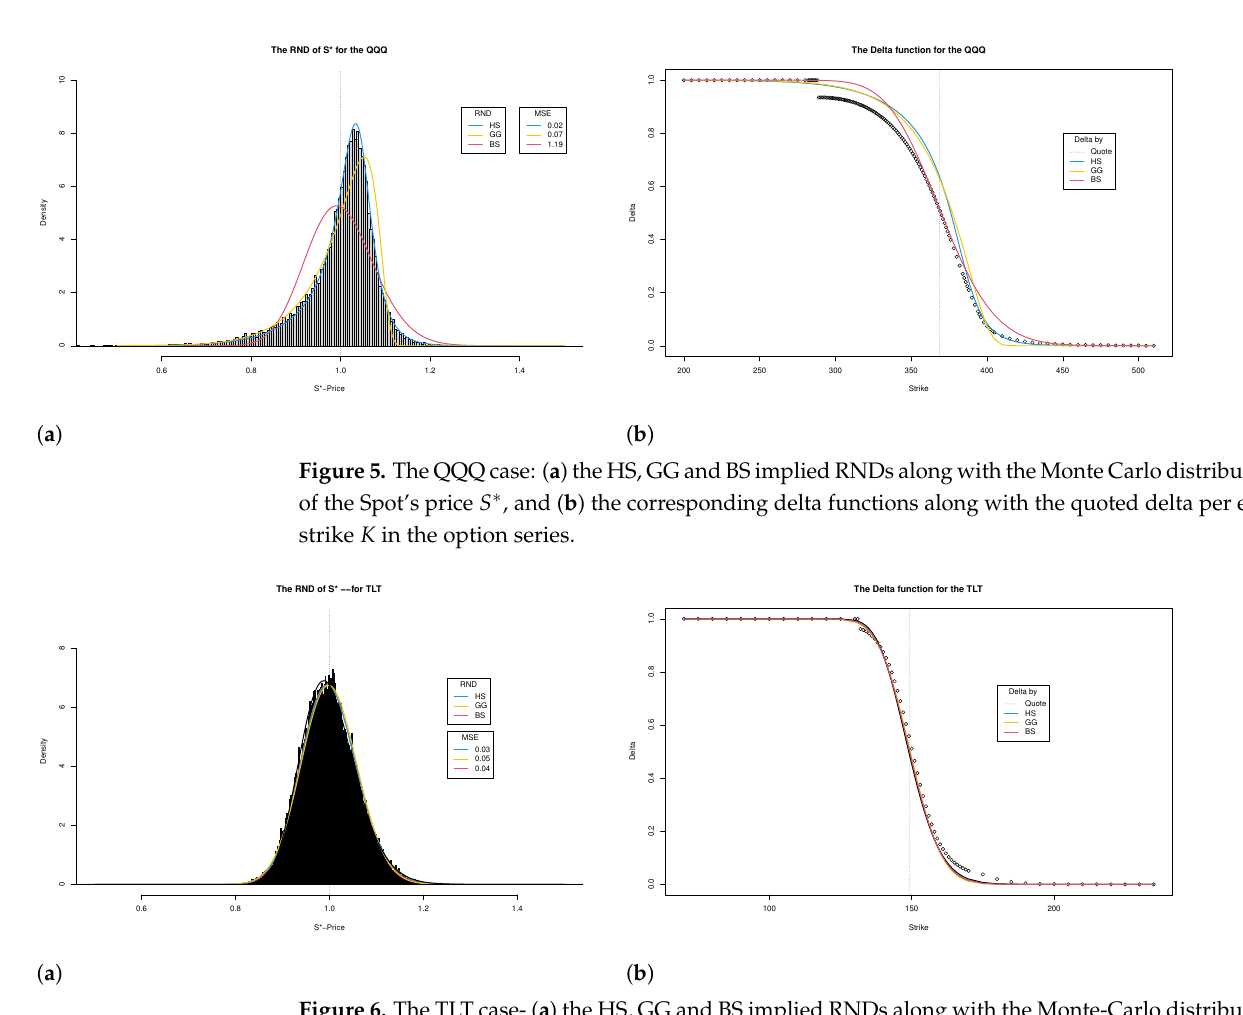
Figure 6. The TLT case- ( a ) the HS, GG and BS implied RNDs along with the Monte-Carlo distribution of the Spot’s price S ∗ , and ( b ) the corresponding delta functions along with the quoted delta per each strike K in the option